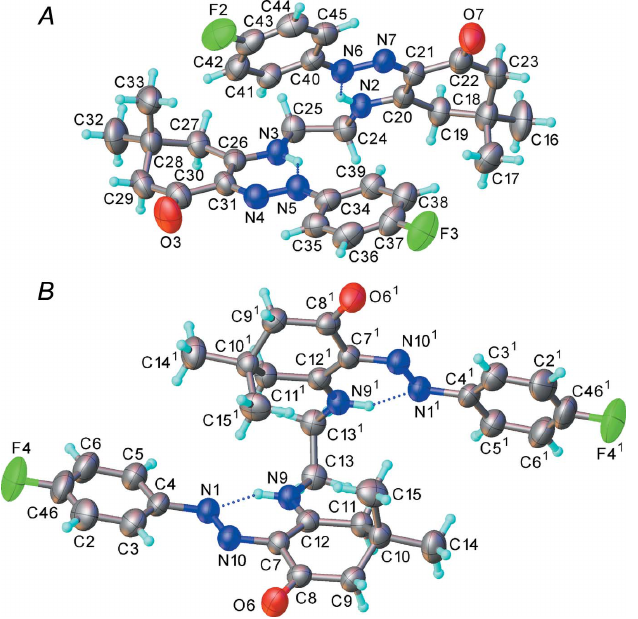
Figure 1 The structures of molecules A and B . Displacement ellipsoids are drawn at the 40% probability level.